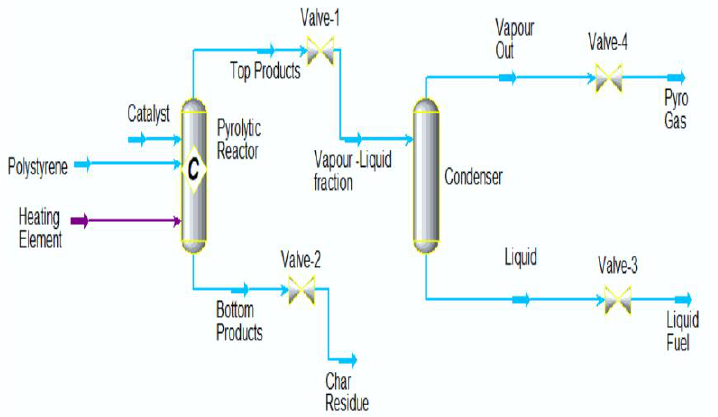
Figure 13. Simulation environment of the Aspen Hysys simulation model for the catalytic cracking of PS. Reprinted with permission from ref. [44].